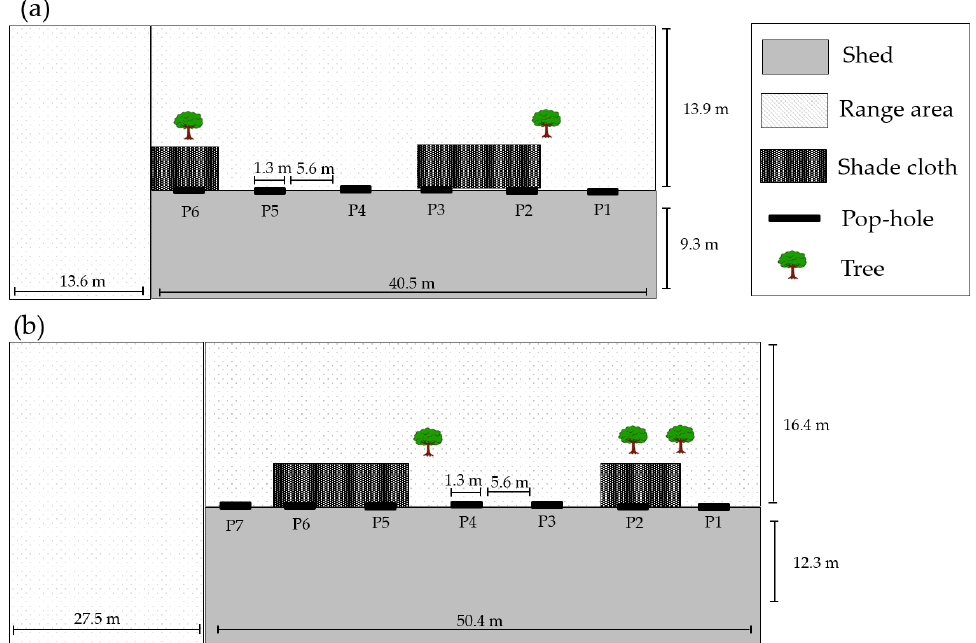
Figure 1. Diagram of study sheds and range areas ( a ) shed one, flocks A and C and ( b ) shed two, flocks B and D. Pop-holes are numbered (P1–P7) sequentially from the front of the shed (shed access point).